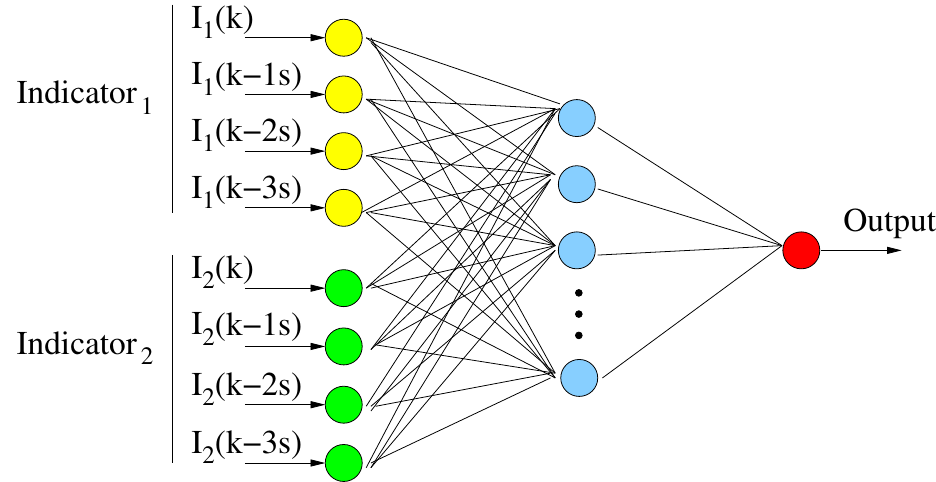
Figure 9. The designed feed forward neural